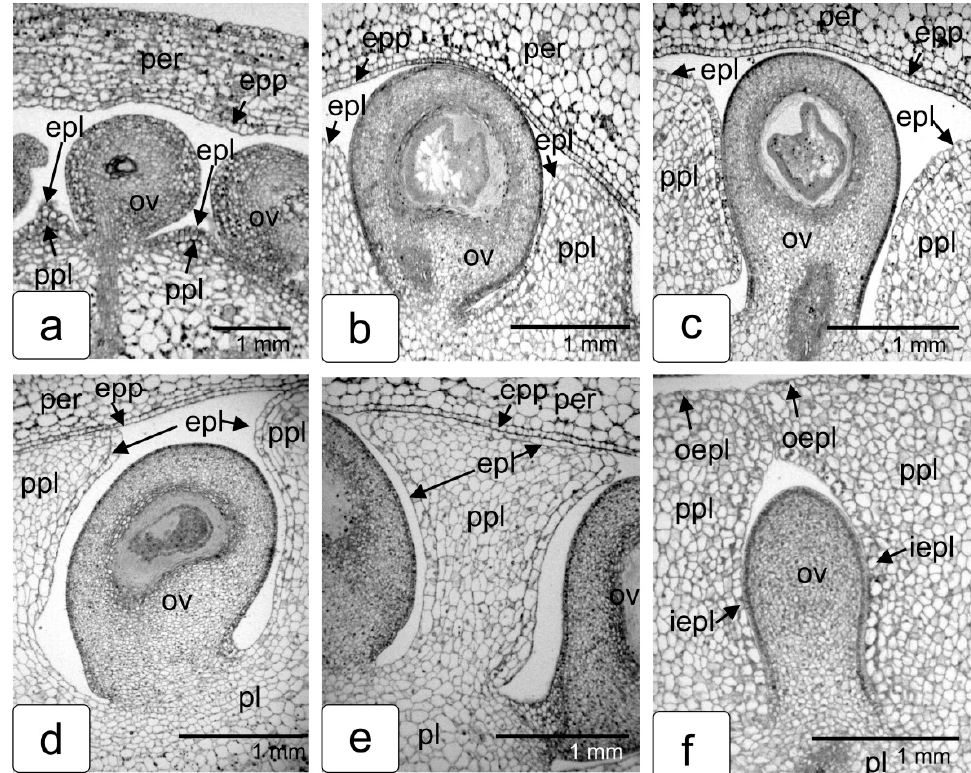
Figure 2. Structural illustration of the process of seed capsule formation during tomato fruit de- velopment. Appearance of outgrowths of the lateral placenta between the developing ovules ( a ); elongation of these outgrowths towards the pericarp ( b , c ); subsequent encirclement of each ovule by the growing placenta ( d – f ). The inner parts of the epidermis of the placenta surrounding each ovule form a capsule shell ( f ). Designations: epl—epidermis of placenta; epp—epidermis of pericarp; iepl—inner epidermis of protruding placenta tissue; int—integument; oepl—outer epidermis